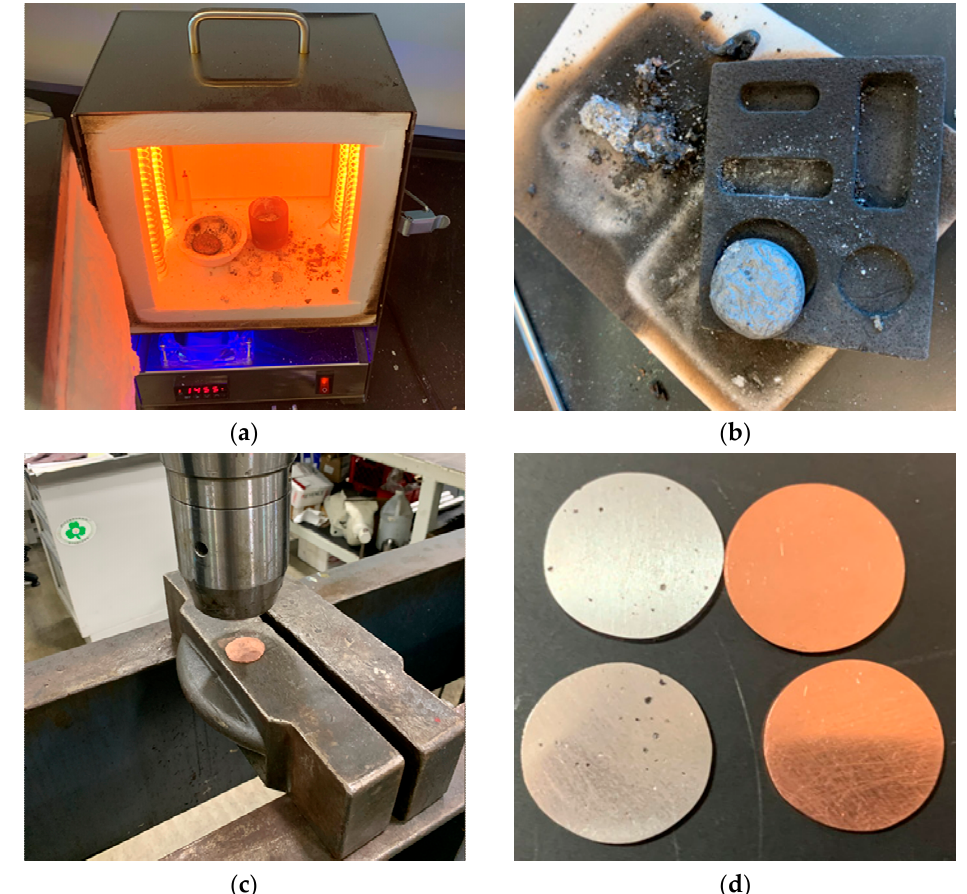
Figure 2. ( a ) Tabletop furnace used for melting, ( b ) mold for forming disks from molten material, ( c ) press for forming the samples (DAKE-50 Tone), and ( d ) polished and pressed CC disks.